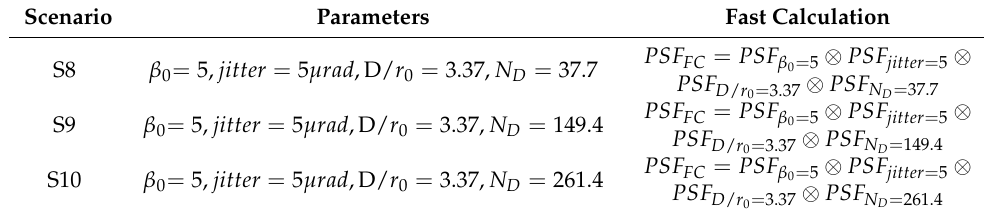
Figure 12. The absorption coefficient and extinction coefficient vary with height. Table 5. Fast calculation with PSF convolution